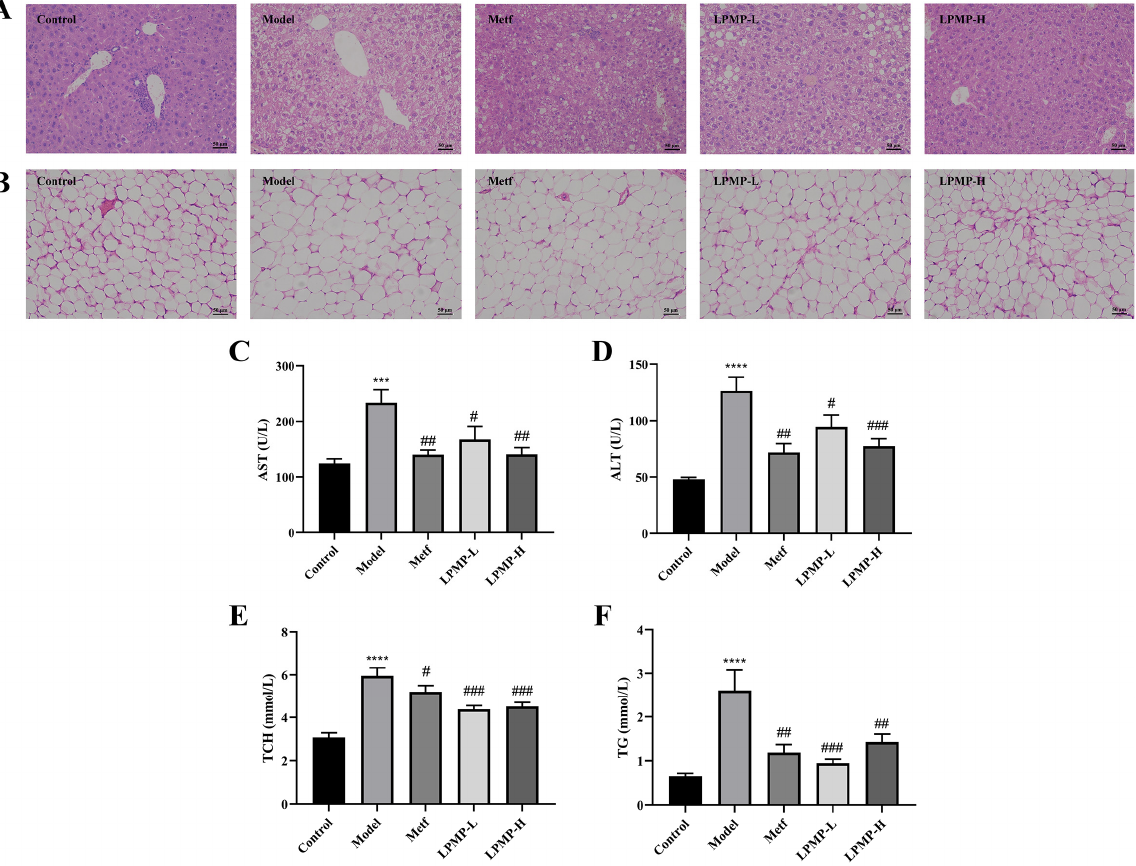
Figure 9. Effect of LPMP on the pathological changes of liver ( A ) and adipose ( B ) tissue. H&E staining was conducted to observe the pathological changes under 200 × magnification. Control: 5 mL/kg/day water; Model: 5 mL/kg/day water; Metf: 225 mg/kg/day metformin; LPMP-L: 20 mg/kg/day LPMP; LPMP-H: 100 mg/kg/day of LPMP. Serum levels of AST ( C ), ALT ( D ), TCH ( E ), and TG ( F ) in diabetic mice. The results shown are means ± SEM ( n = 8). **** p < 0.001, *** p < 0.001 versus control group; # p < 0.05, ## p < 0.01, ### p < 0.001 versus model group.